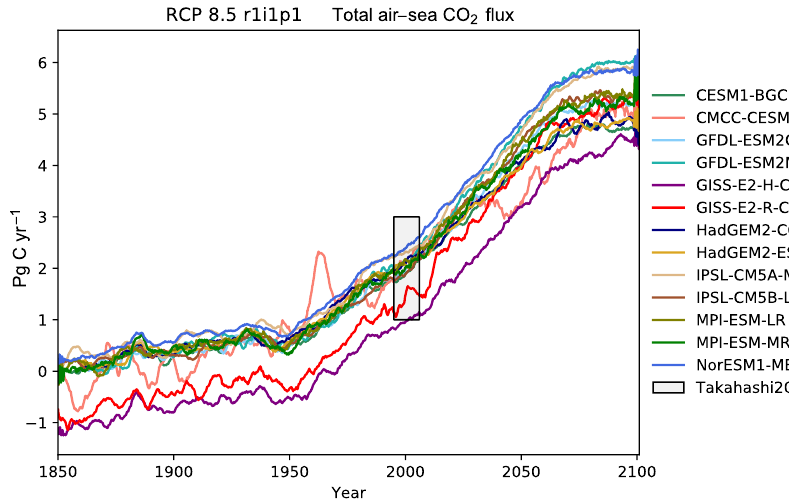
Figure 14. The total annual flux of CO 2 from the air to the sea in Pgyr − 1 under the RCP8.5 scenario